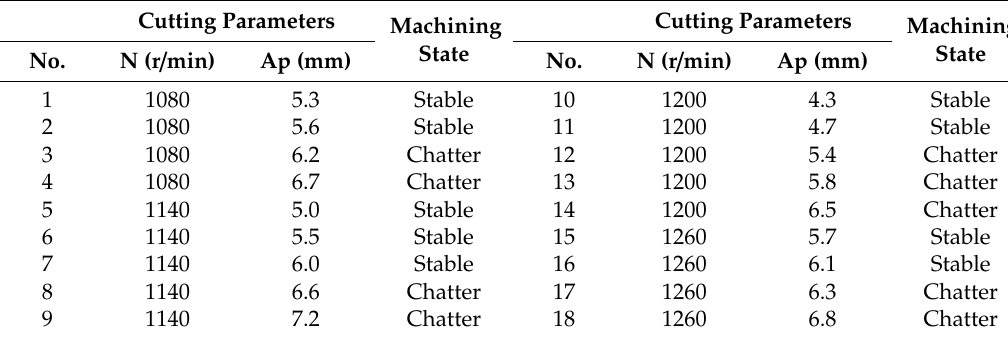
Table 3. Machining state with di ff erent